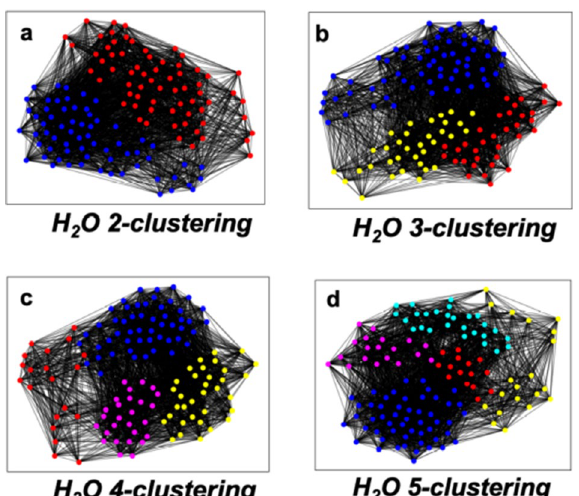
Figure 2. Showing H 2 O 2- , 3- , 4- , and 5-clustering from Quantum Community Detection on the D-Wave Quantum Annealer. For all the k-clusterings , the cluster or community of nodes with the lowest energy is shown in blue. ( a ) The 2-clustering produced communities of size 68 (red) and 65 (blue). ( b ) The 3-clustering is shown with communities of size 34 (red), 65 (blue), and 34 (yellow). The 2- and 3-clustering share the same low energy cluster of 65. ( c ) The 4-clustering produced communities of size 20 (red), 52 (blue), 34 (yellow), and 27 (magenta). ( d ) The 5-clustering resulted in communities of size 15 (red), 52 (blue), 20 (yellow), 19 (magenta), and 27 (cyan). The 4- and 5-clustering share the same low energy cluster of 52. The clustering pictures were generated using NetworkX 2.5 31 (https:// netwo rkx. org) and Matplotlib 3.3.3 32 (https:// matpl otlib.